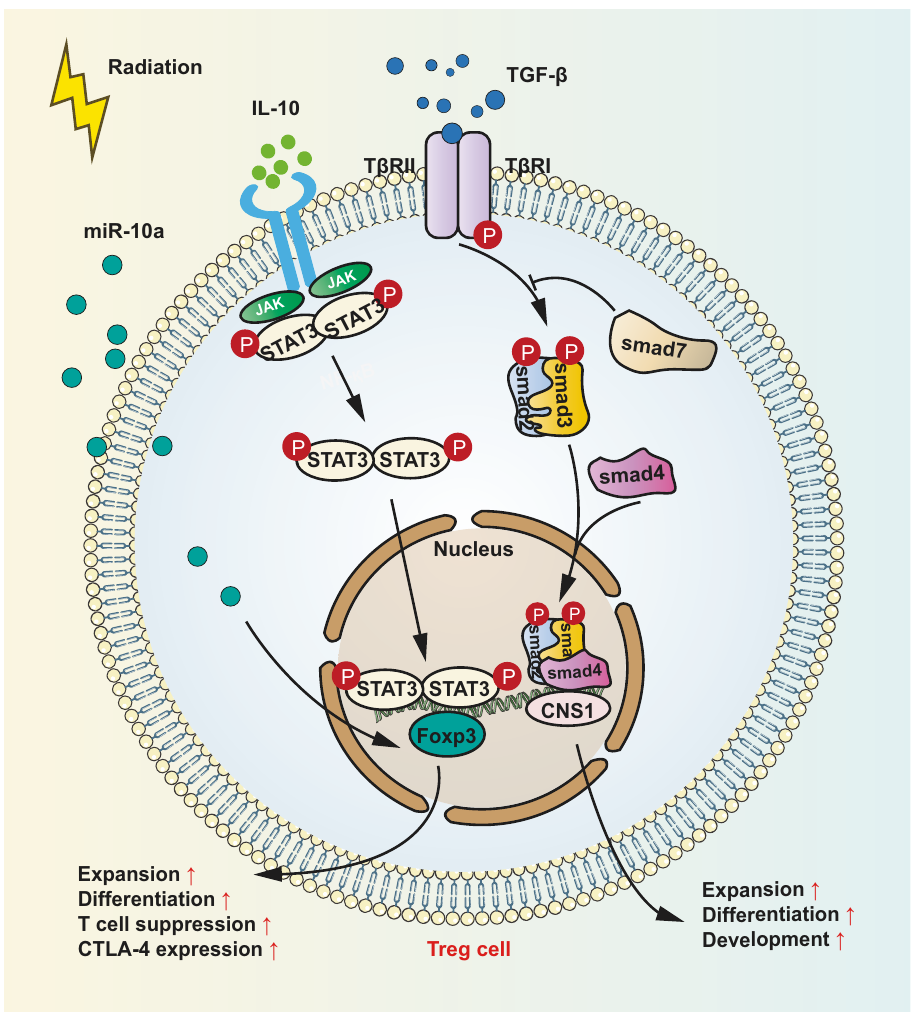
Fig. 2 Immunomodulatory effect of radiation on Treg cells. Radiation promotes the conversion from CD4 + T cells to Treg cells and enhances Treg function through IL-10R-mediated STAT3 signaling pathway. Radiation also increases the secretion of IL-10 which can bind to IL-10 receptors. This binding activates JAKs and activated JAKs, such as JAK1 and JAK2, phosphorylate STAT3 at Tyr705, resulting in translocation of activated STAT3 dimers to the nucleus. STAT3, as a cotranscription factor with FOXP3, promotes expansion, differentiation, and T cell suppression and increases CTLA-4 expression of Treg cells. In addition, miR-10a induced by radiation can enhance the expression level of FOXP3 and promote the differentiation of Treg from naive CD4 + T cell. Radiation increases the level of TGF- β in the TME greatly and TGF- β recognizes and binds TGF β RII, which then phosphorylates TGF β RI. TGF- β activates Smad2 and Smad3 and promotes the formation of a heterotrimer with Smad4. Smads are recruited to the CNS1 region which has been identi fi ed at the Foxp3 gene locus. The CNS1 promotes generation, expansion, differentiation, and development of Treg cells. Parts of this fi gure were drawn with aid of Servier Medical Art (http:// www.servier.com), licensed under a Creative Commons Attribution 3.0 Unported License. Parts of this fi gure were drawn with aid of